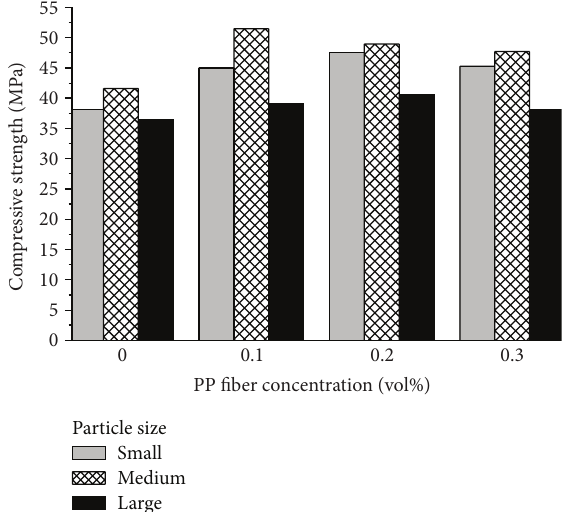
Figure 1: Compressive strength of polymer concrete with different marble particle sizes and fiber concentrations.